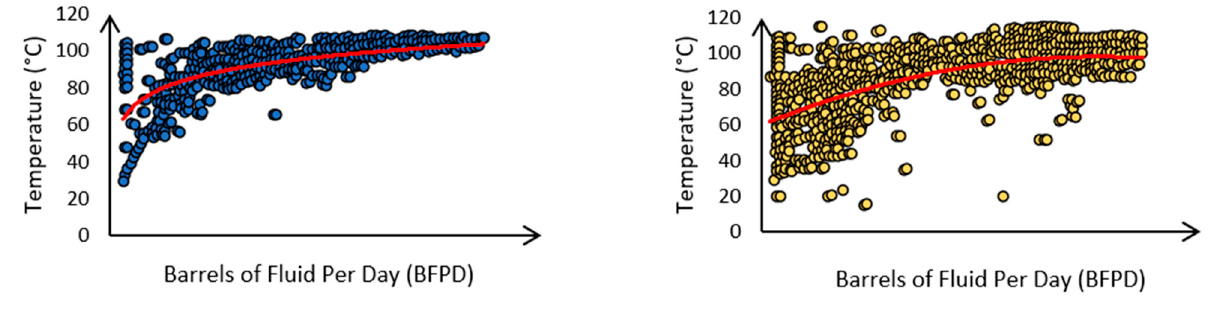
Figure 3. The relationship between the magnitude of the produced water flow and produced water temperatures for ( a ) OFA and ( b ) OFB. The blue circles indicate the measurements made in different wells for oilfield A. The yellow circles indicate the measurements made in different wells for oilfield B.